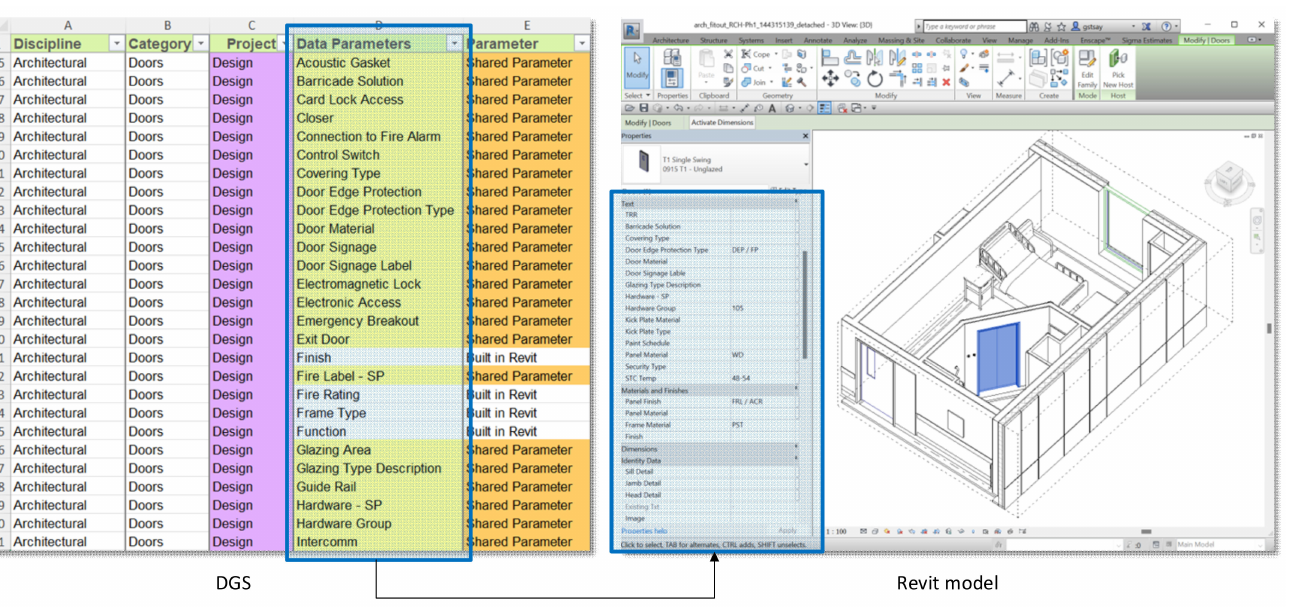
Figure 11. Schematic example of the asset information required in the DGS being incorporated into the Revit models during